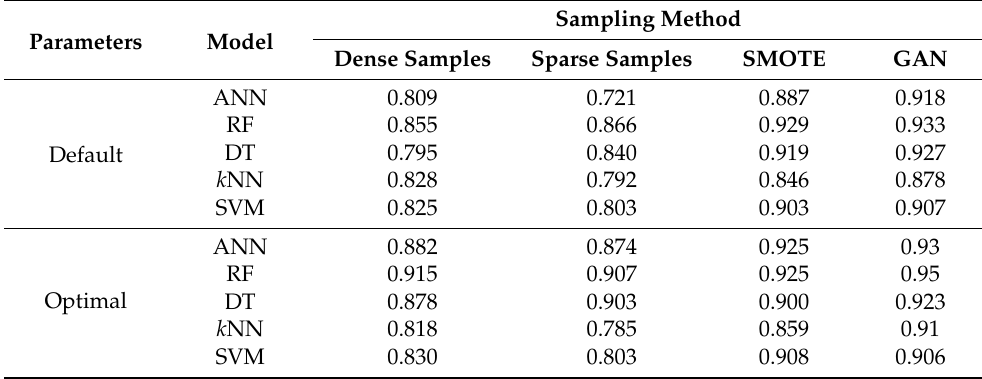
Table A4. Assessment of different sampling methods used in this study with five machine learning models (both default and optimised parameters)–based on